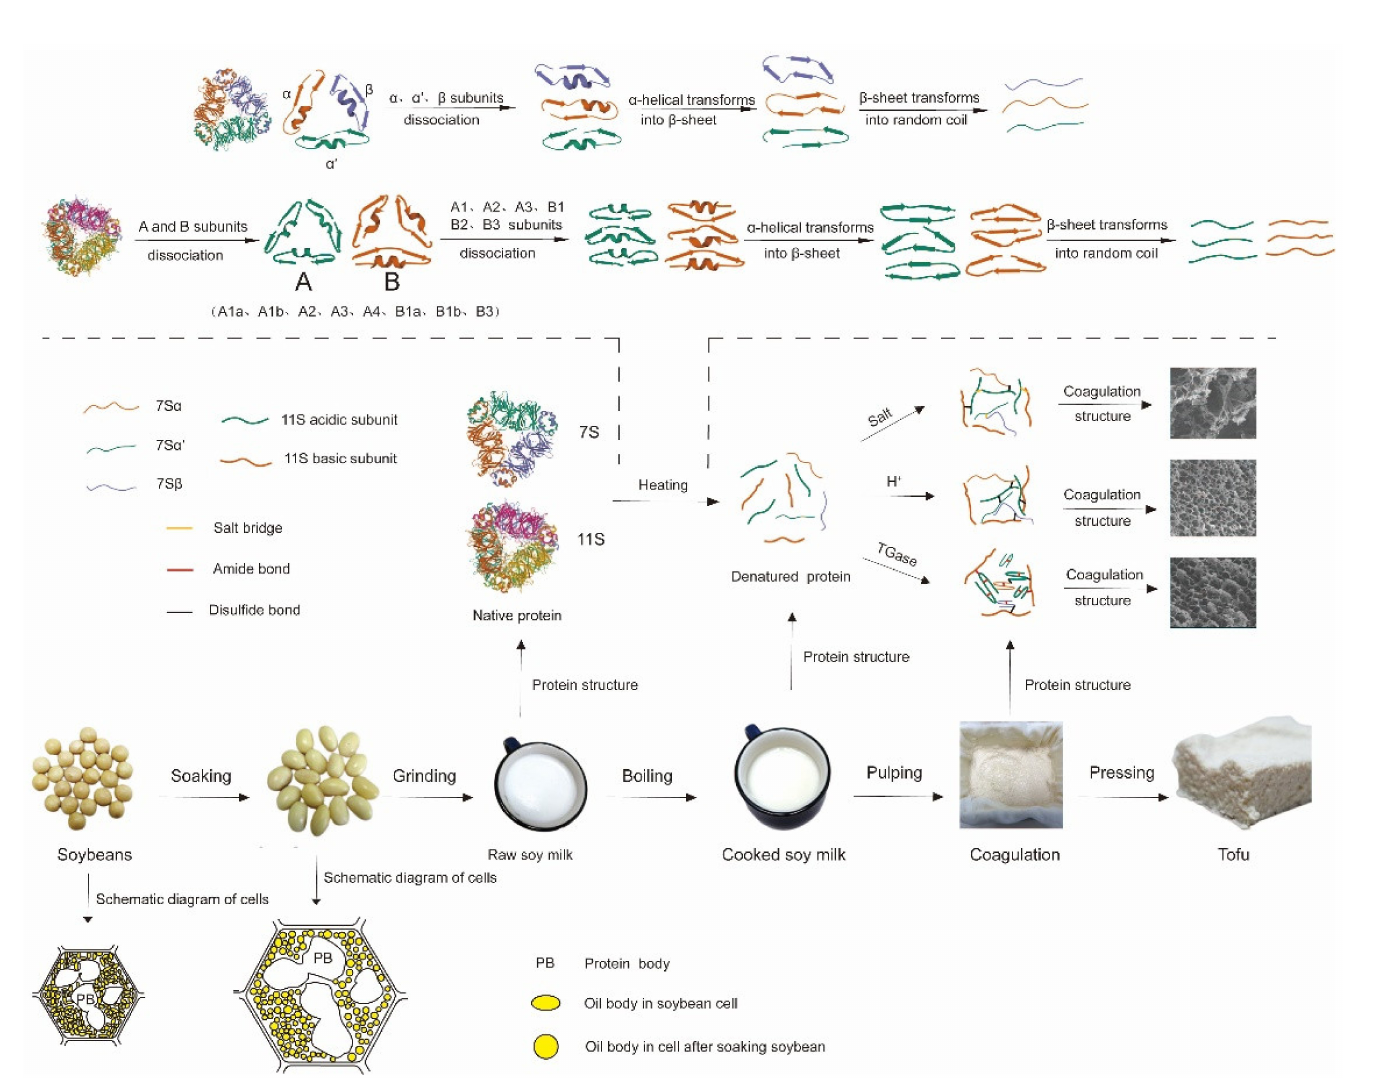
Figure 2. Changes of soybean protein during tofu processing [5,6]; Protein Data